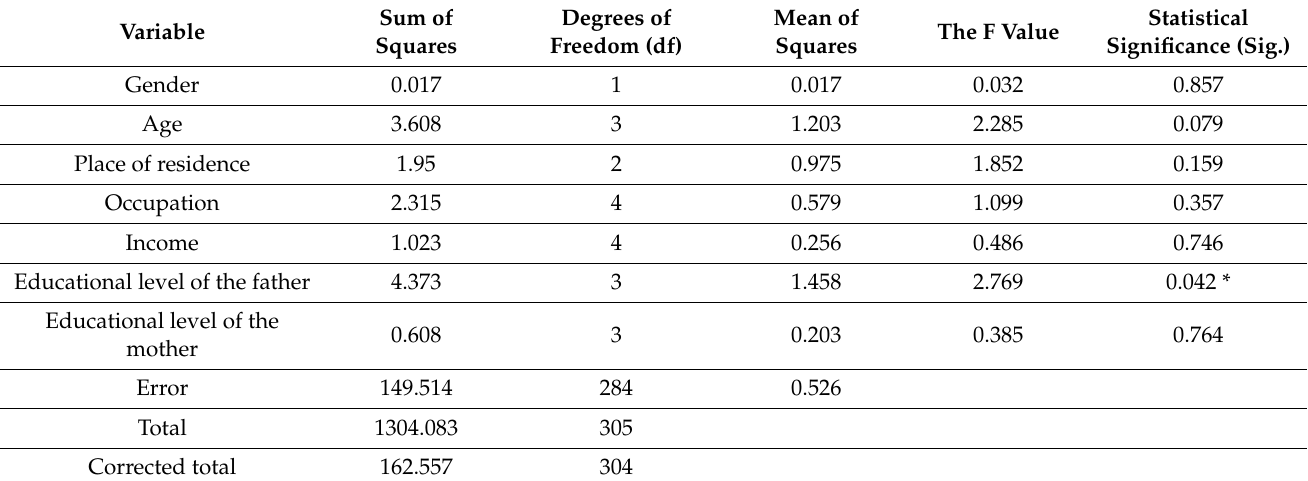
Table 6. MANOVA test of the difference in the level of the familial obstacles to youths’ participation in voluntary work when considering the demographic